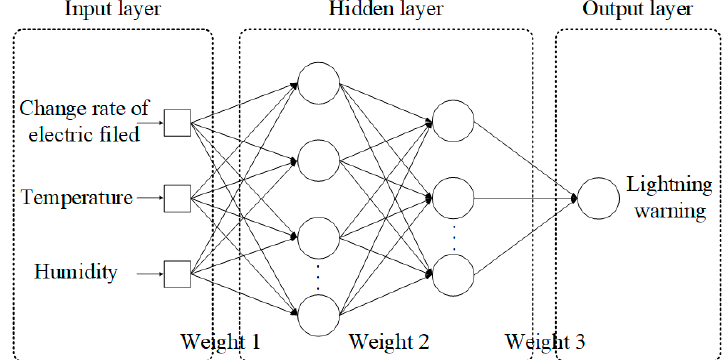
Figure 8. Structure of artificial neural network.